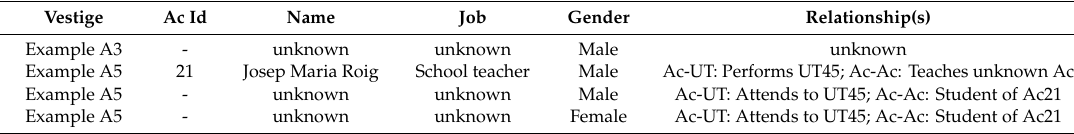
Table A5. Simplified Ac dataset gathered from Examples A3, A4, and